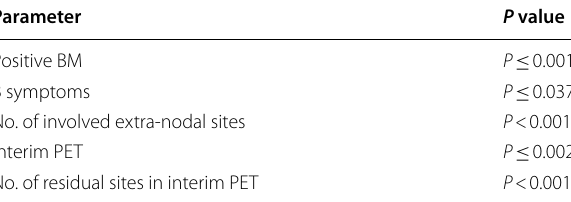
Table 8 P values of significantly correlated clinical factors Parameter